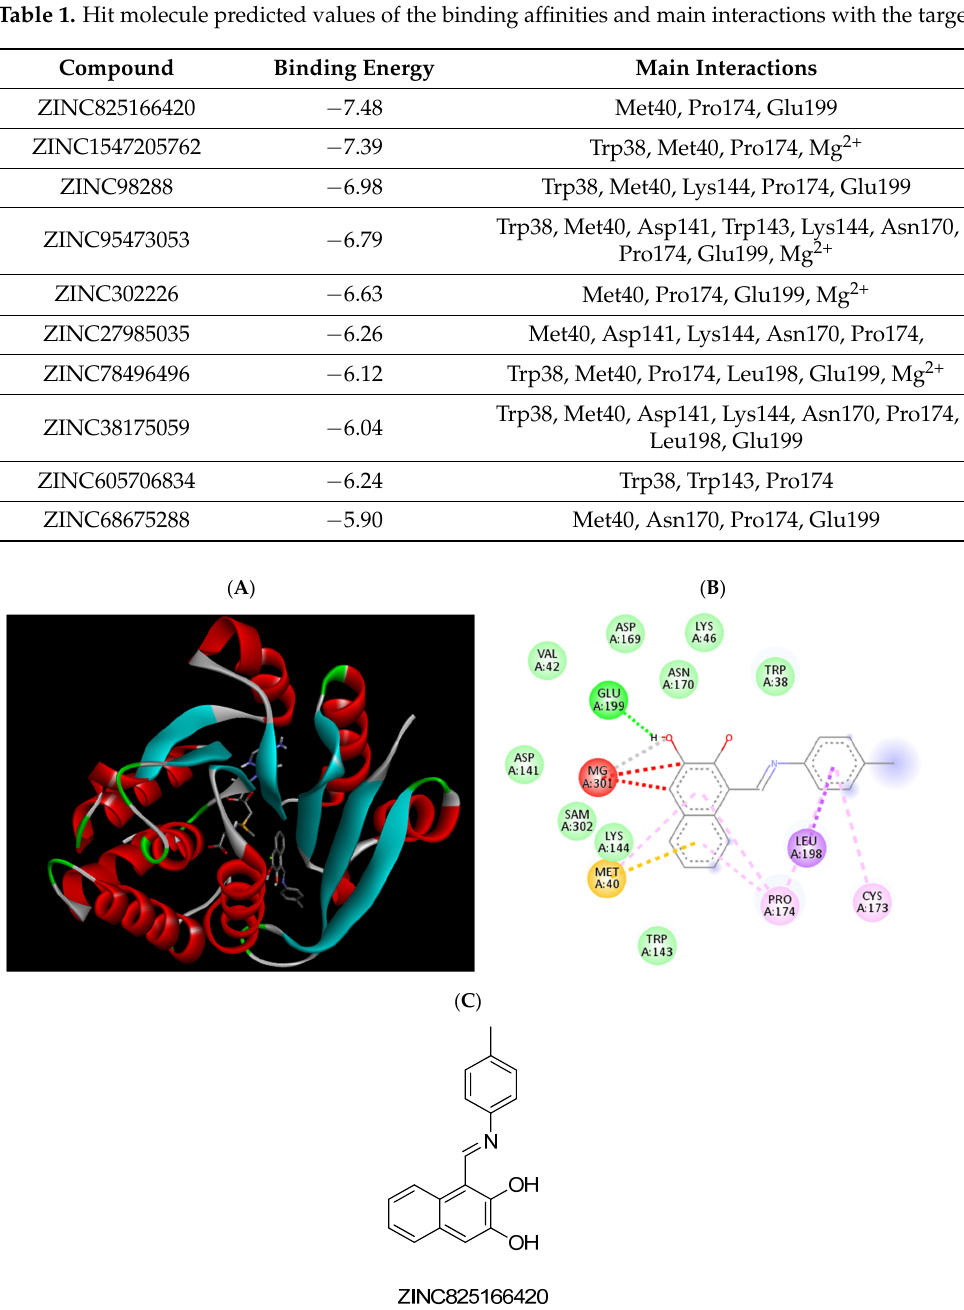
Figure 3. ( A ) Binding modes of ZINC825166420 with the crystal structure of human COMT complexed with SAM and Mg 2+ , ( B ) receptor–ligand interactions, ( C ) 2D representation of